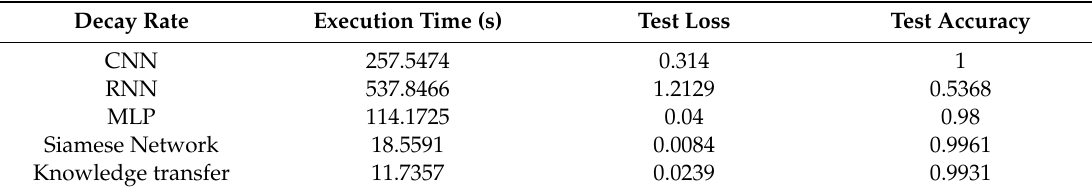
Table 24. Comparison of neural